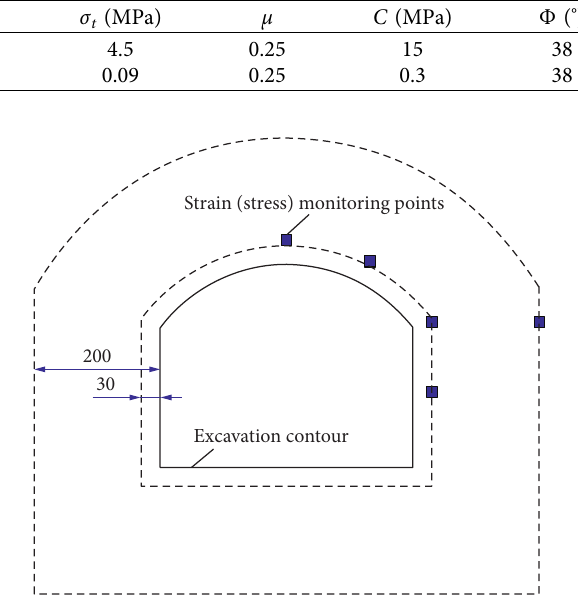
Figure 9: Strain brick and micro Earth pressure cell arrangement (unit: